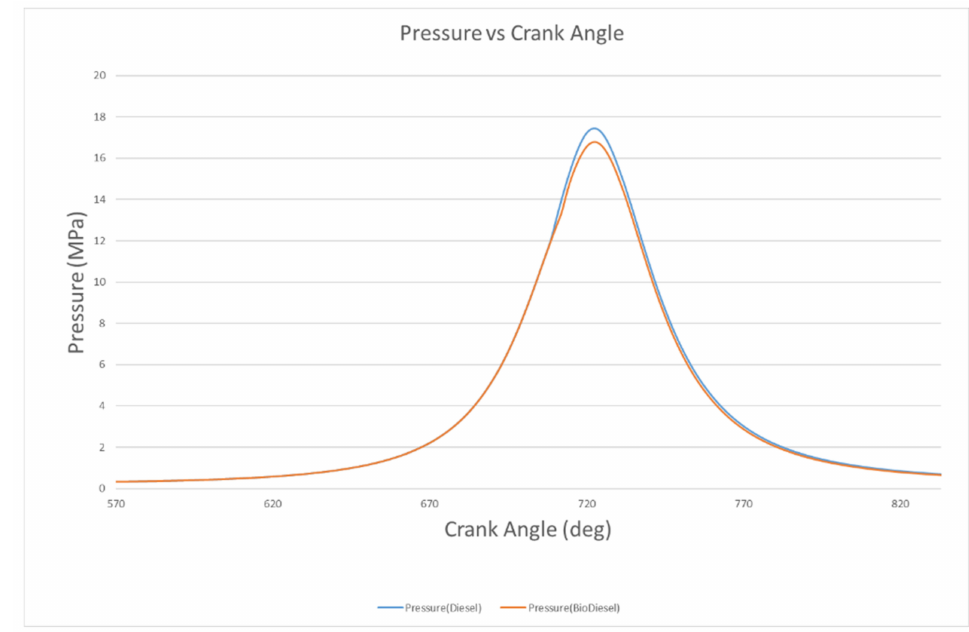
Figure 5. Pressure vs. crank